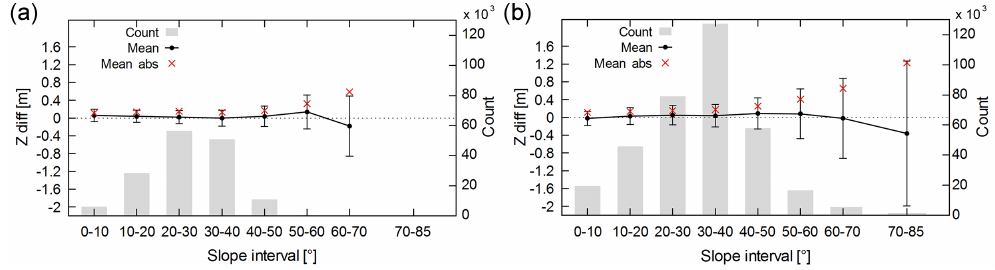
Figure 15. Mean, mean of the absolute values and standard deviation of elevation differences between 2014 SfM–MVS and ALS-based DEMs calculated for 10 ◦ intervals of slope (a) within the reconstructed area of the rock glacier and (b) on the bare ground outside the rock glacier.